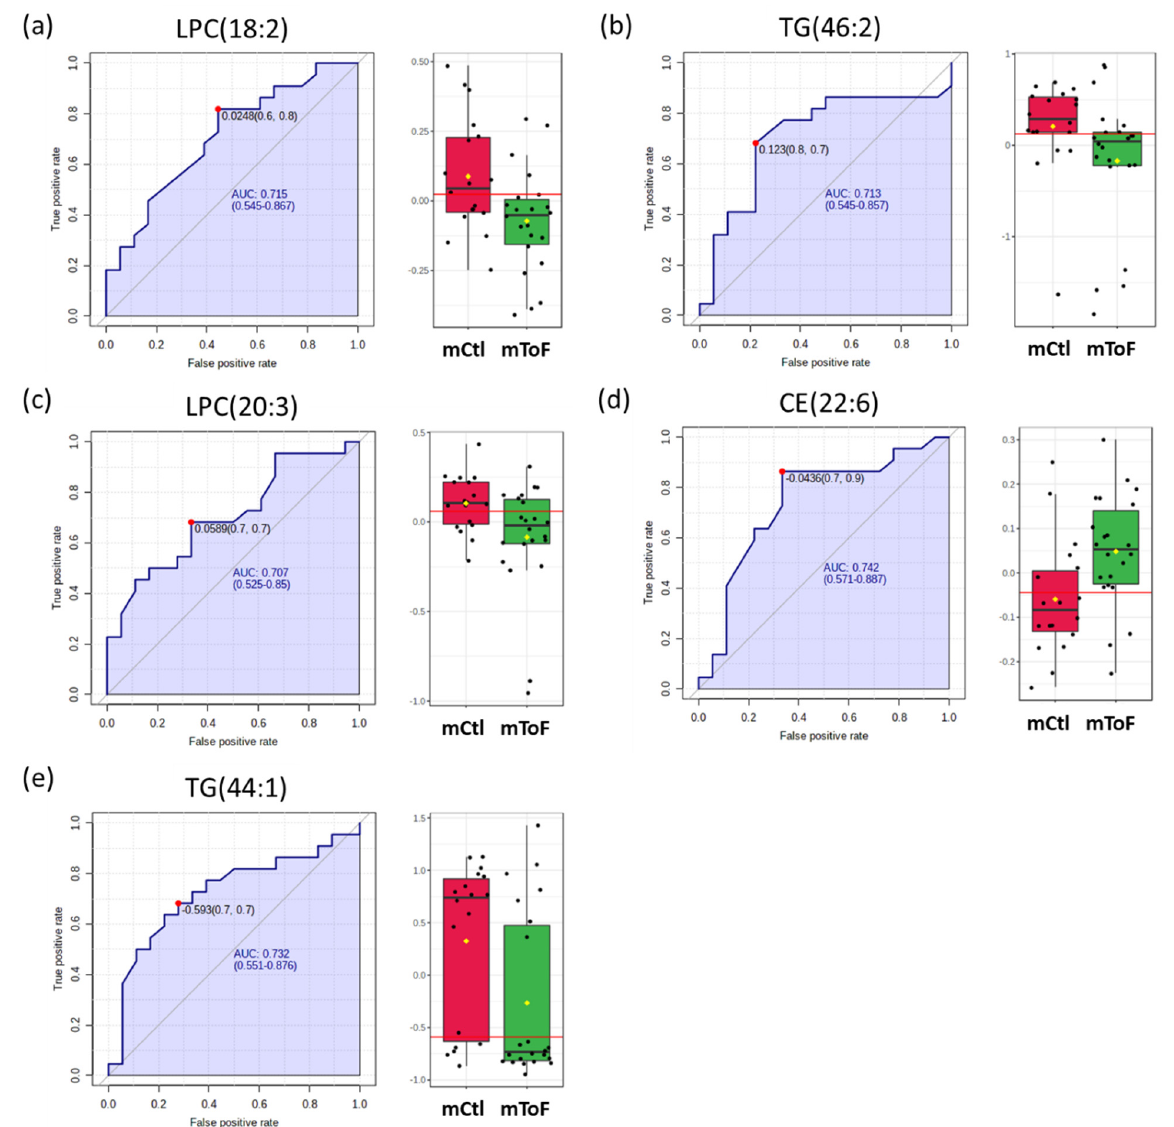
Figure 6. Biomarker analysis for the predictive values metabolites for mToF. The sensitivity (true positive rate) is on the y -axis, and the specificity (one minus the false positive rate) is on the x -axis, with the area under the curve (AUC) > 0.70 on six metabolites, including ( a ) LPC (18:2), ( b ) TG (46:2), ( c ) LPC (20:3), ( d ) CE (22:6), and ( e ) TG (44:1). A horizontal line in red in the box plots indicates the optimal cutoff of between two